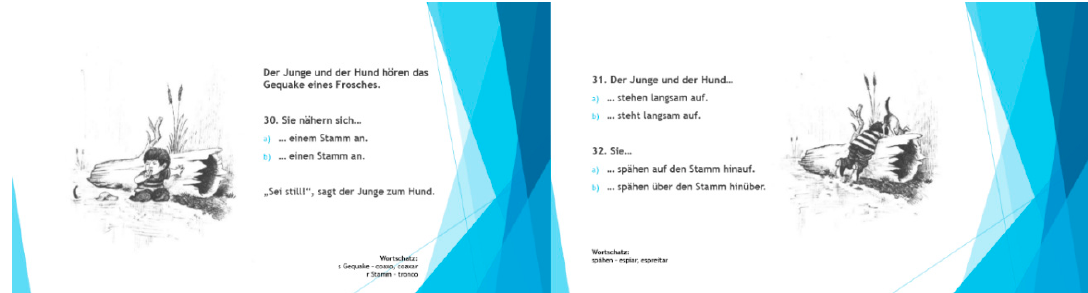
Figure A39. Posttest: Binary-choice recognition task.